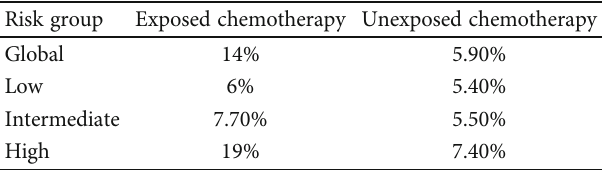
Table 12: Death rate by risk group according to exposure to joint chemotherapy